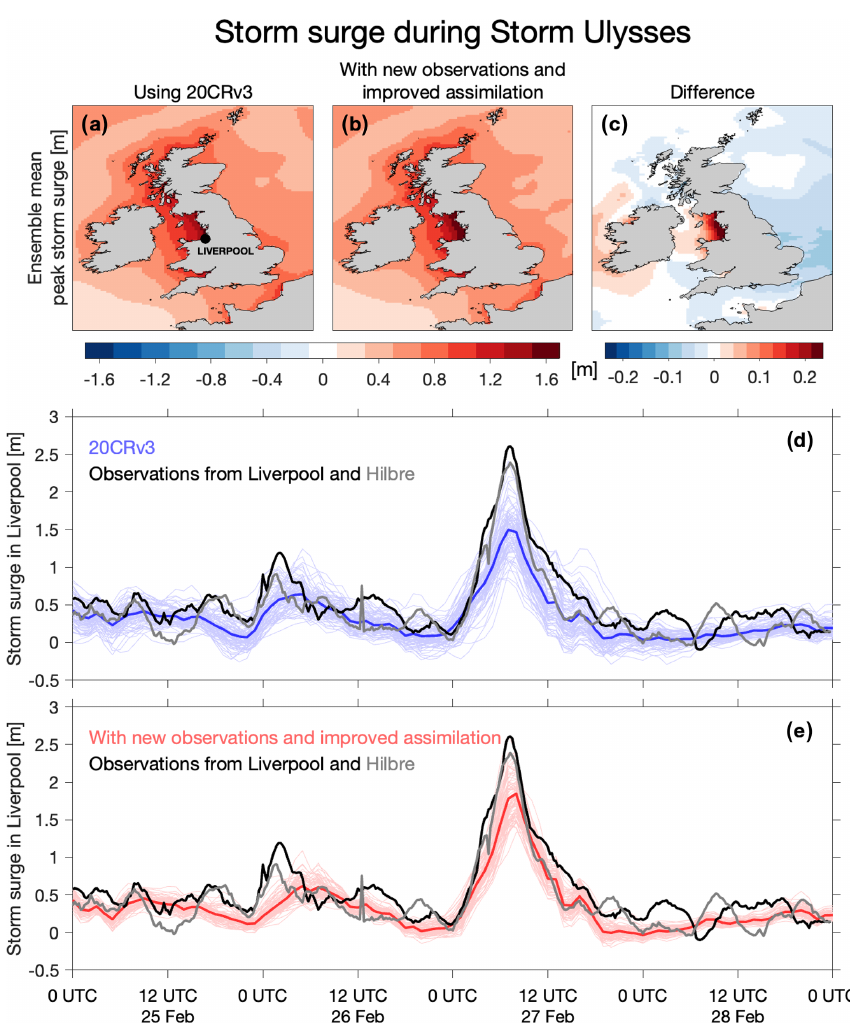
Figure 9. Storm surge simulations for Storm Ulysses. Top: maps of the ensemble mean of the maximum storm surge during Storm Ulysses, for two versions of the reanalysis (a, b) , and the difference (c) . Bottom: simulated storm surge height at Liverpool for each ensemble member (thin lines) and ensemble mean (thick lines) using two versions of the reanalysis (d, e) , compared with the newly rescued tide gauge observations for Liverpool Docks and Hilbre Island, for 25–28 February